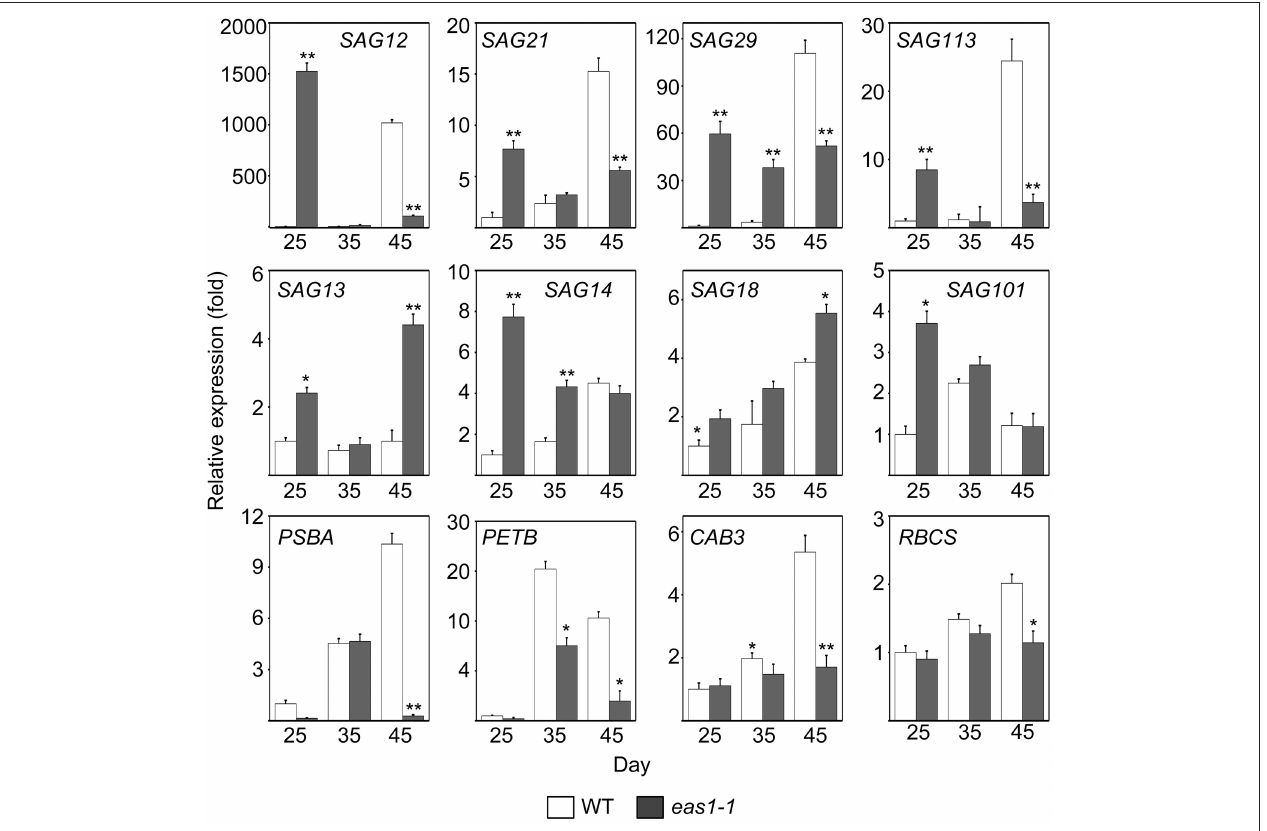
FIGURE 3 | Expression analysis of SAGs and CRGs in wild-type and eas1-1 mutant leaves for 25, 35, and 45 days under unstressed conditions in soil. SAGs included SAG12 , SAG13 , SAG14 , SAG18 , SAG20 , SAG21 , SAG29 , SAG101 , and SAG113 . CRGs included PSBA , RBCS , CAB3 , and PETB. Actin was used as an internal control. Total RNA was isolated from the sixth and seventh true leaves at the indicated time points. Bars indicate standard errors, while asterisks indicate significant differences from wild-type plants under Student’s test ( * p < 0.05 , ** p < 0.01 ); three experiments were performed with similar